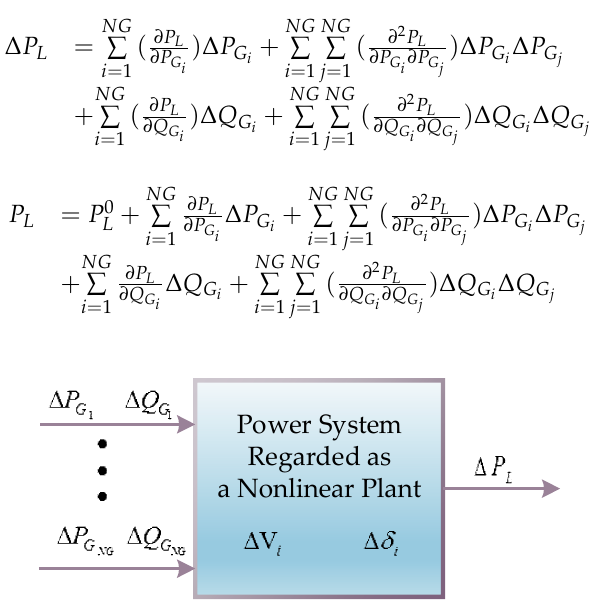
Figure 1. Schematic of the incremental model of a power system.